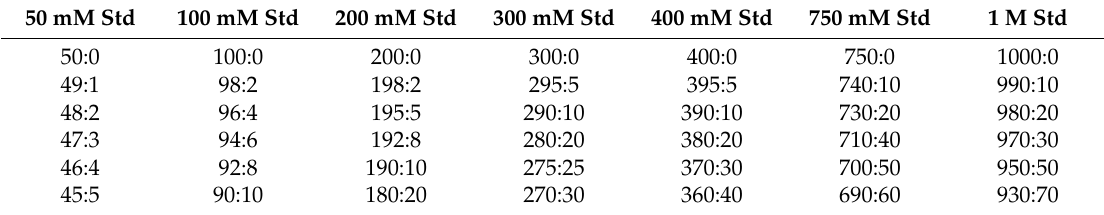
Table A1. Standard series employed during the GOD-POD assays. The ratios represent the amount of mannose and glucose present in the different standards (mm mannose:mm